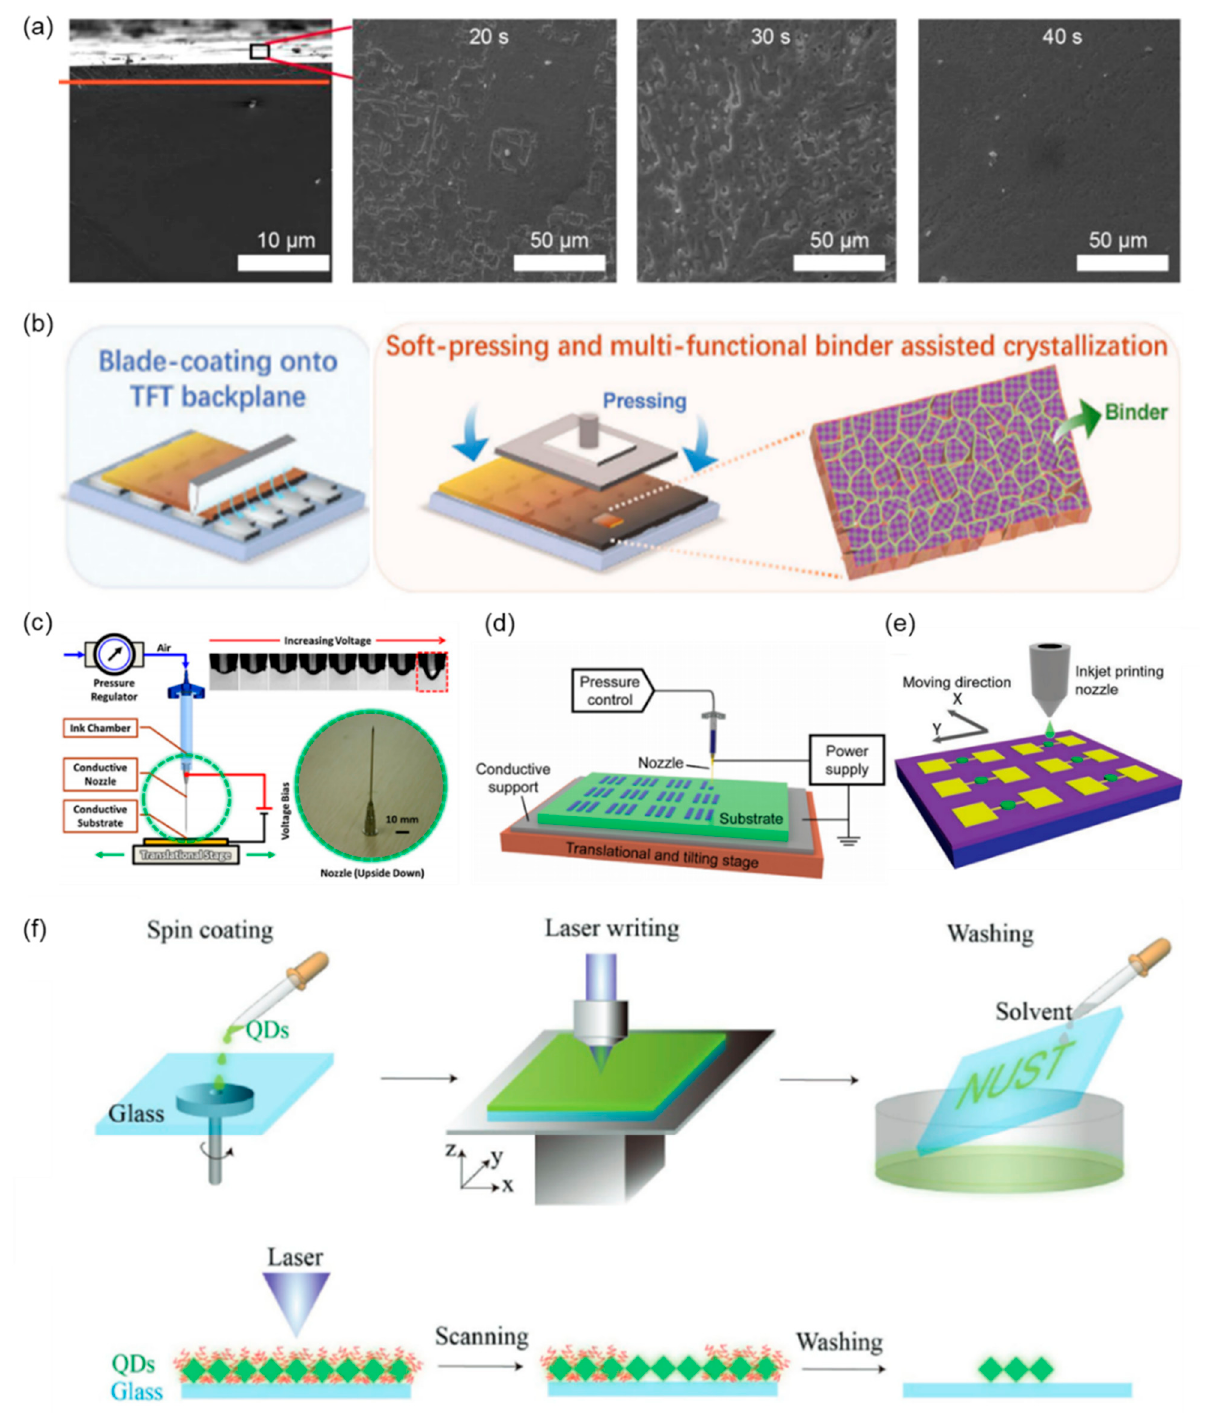
Figure 3. Solution growth, scraper, inkjet printing, and laser direct writing methods. ( a ) SEM photos of epitaxial layer cross-section and solution treatment at different growth times. Reprinted with permission from Ref. [31]. 2020, American Chemical Society. ( b ) Scraper method and a soft pressure-assisted cryogenic solution treatment. Reprinted with permission from Ref. [35]. 2022, Wiley. ( c ) Schematic of inkjet printer. Reprinted with permission from Ref. [39]. 2012, IOP Publishing. ( d ) Schematic illustration of inkjet printing system. Reprinted with permission from Ref. [41]. 2015, Royal Society of Chemistry. ( e ) Schematic diagram of a perovskite-based device manufactured by inkjet printing. Reprinted with permission from Ref. [42]. 2019, Wiley. ( f ) Schematic diagram of the modeling process and mechanism of perovskite colloidal quantum dots. Reprinted with permission from Ref. [43]. 2017, Wiley.